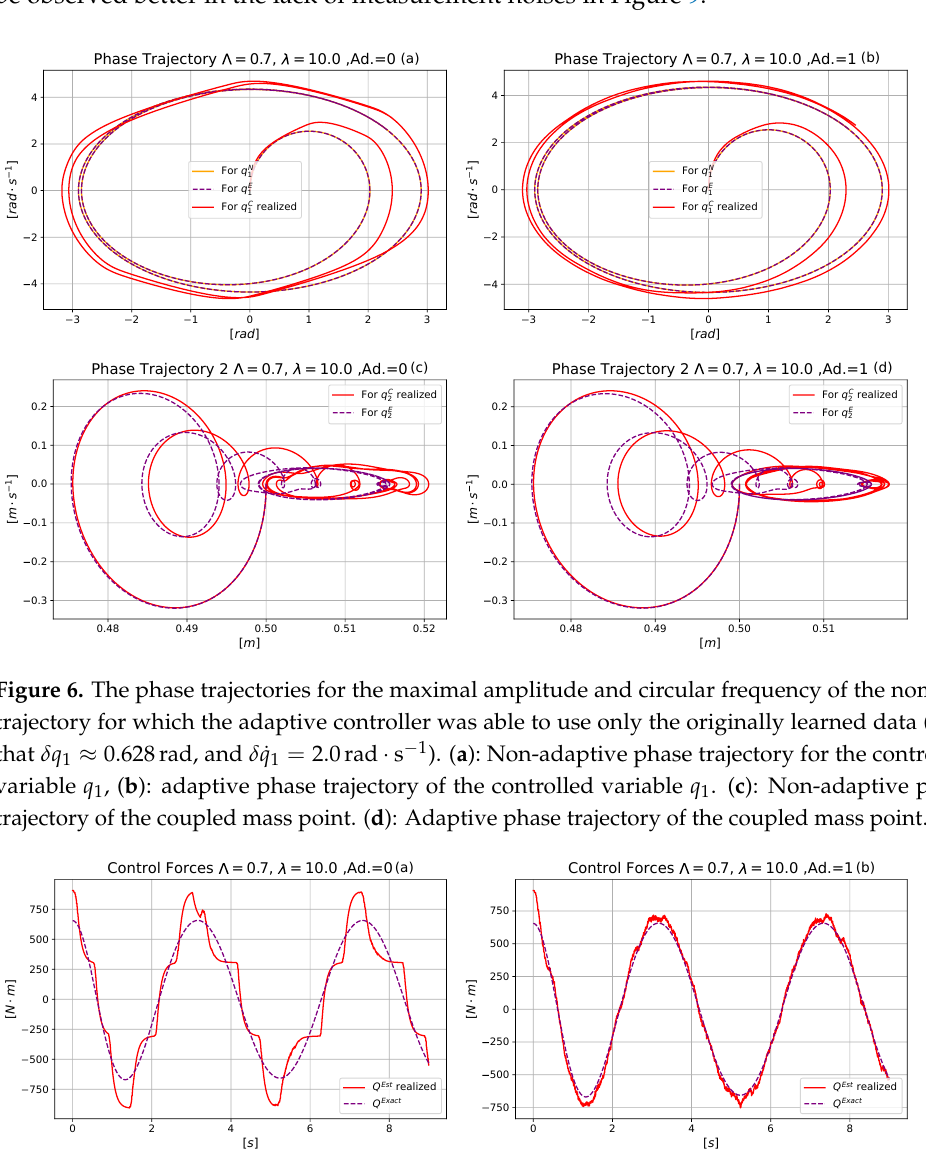
Figure 7. The control torque Q 1 for the maximal amplitude and circular frequency of the nominal trajectory for which the adaptive controller was able to use only the originally learned data. ( a ): Non- adaptive, ( b ): adaptive